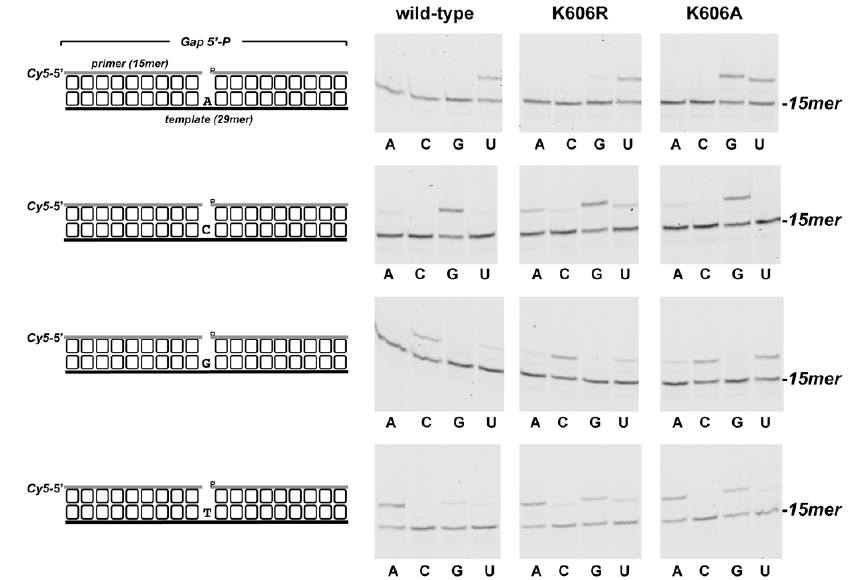
Figure 7. Nucleotide insertion fidelity by Pa -PolDom wild-type and mutants K606R and K606A at 1 nt gapped DNA. The four different 1 nt gapped structures used, differences in the templating base are shown on the left. The assay was performed as described in Materials and Methods with 10 nM of the indicated substrate, 5 nM of either the wild-type or the specified Pa -PolDom mutant, and 50 nM of the indicated NTP . Samples were incubated at 30 °C for 3 min, products were resolved by denaturing PAGE and further visualized using a Typhoon 9410 scanner (GE Healthcare).